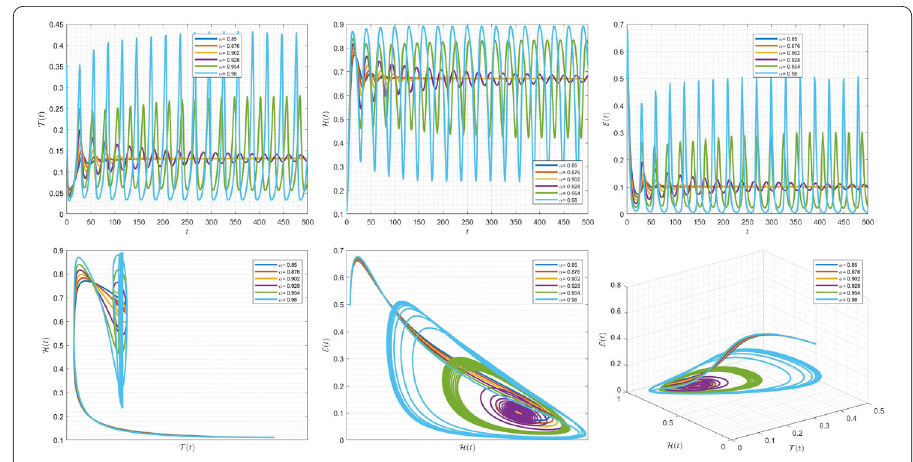
Figure 3 Simulations for solving (7) using (26) along with ( T (0), H (0), E (0)) = (0.3517,0.1115,0.4951) and β 12 =